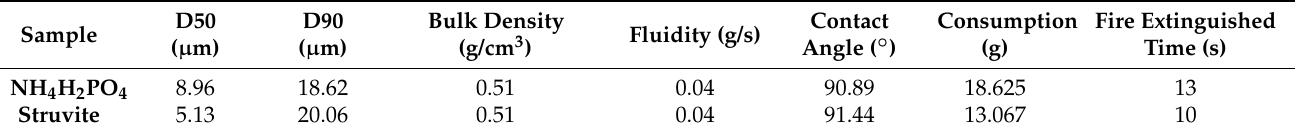
Table 3. The characteristics test results of the above two ultrafine dry